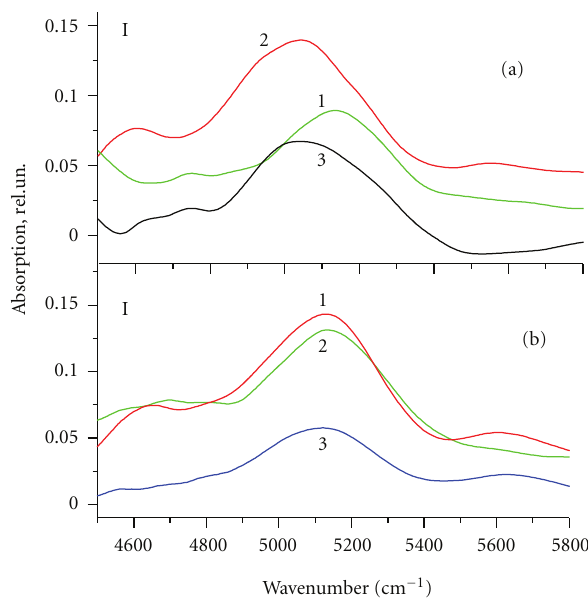
Figure 5: The absorption spectra of H 2 O in bone of healthy (a) and osteoporotic (b) rats in the 4570–5300cm − 1 , recorded in 10 (1), 20 (2), 30 (3), minutes after the start of vacuum pumping. The error bars represent the corresponding 95% confidence